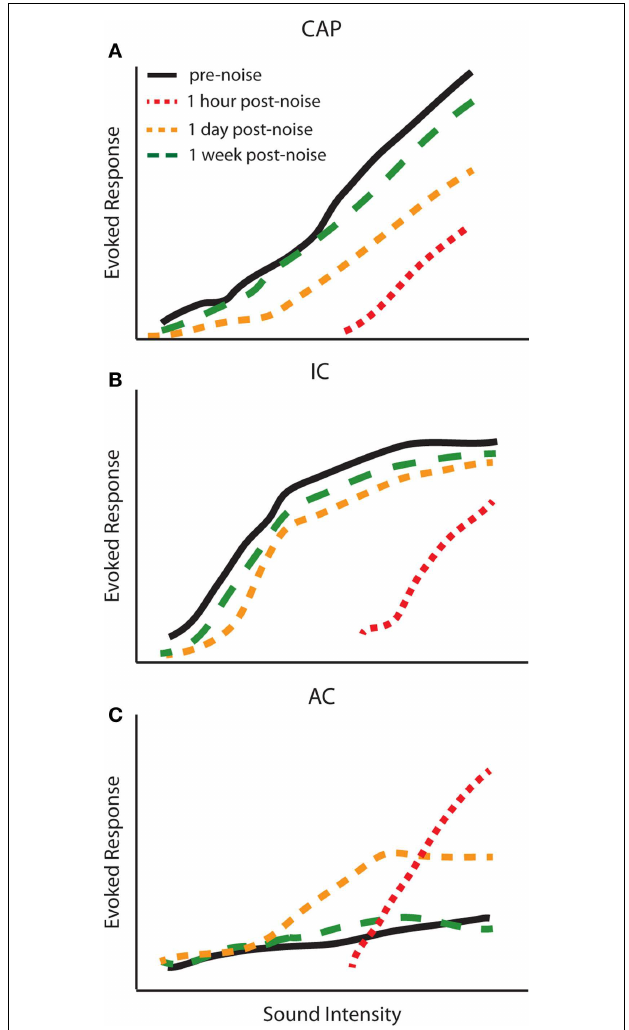
FIGURE 4 |Temporal dynamics of central gain enhancement . Schematized data representing the temporal dynamics of noise-induced changes to amplitude-level functions in response to click stimuli from the (A) compound action potential (CAP), (B) inferior colliculus (IC), and (C) auditory cortex (AC).The amplitude-level functions were computed from chronic recordings of CAP and LFPs from the IC and AC before (black lines), 1h (red lines), 1day (yellow lines), and 1week (green lines) post-noise-exposure.The parameters for noise-exposure were white broadband noise at 115dB SPL for 1h [modified from Ref.